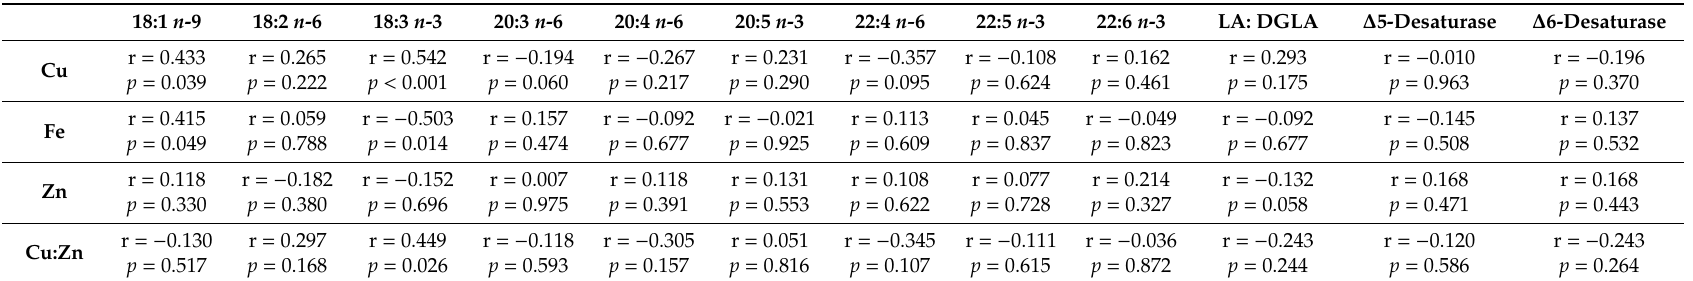
Table 3. Correlations of plasma concentrations of trace elements (Zn, Fe, Cu) and Cu:Zn ratio with plasma fatty acids and estimated desaturase activity in study